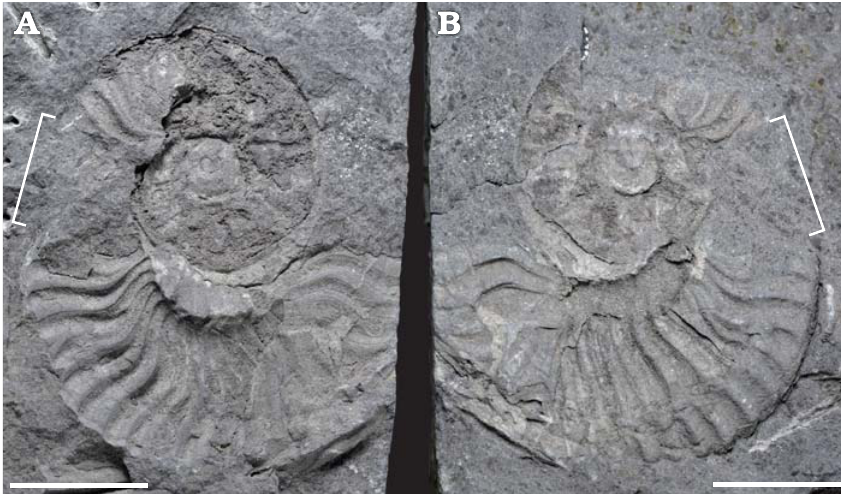
Fig. 5. Example of ventral breakage in the early Toarcian ammonoid from the Toyora area, pre- served in the cast ( A ) and mould ( B ) of Proto- grammoceras onoi Hirano, 1971, UMUT MM 31437, loc. 18 (for detailed locality information see Fig. 2). The white brackets indicate the posi- tion and extent of the breakage. Scale bars 10